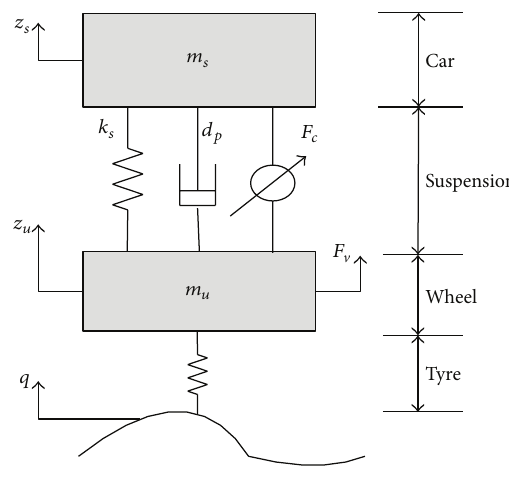
Figure 1: Quarter-car